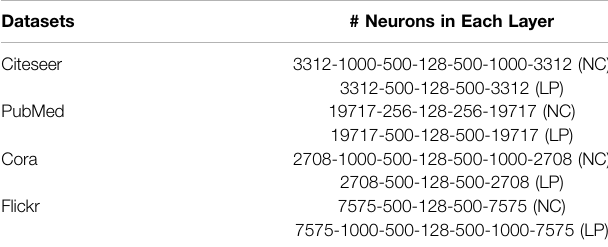
TABLE 4 | Detailed architecture information for datasets ( DANRL-CA-AM/ Multilevel